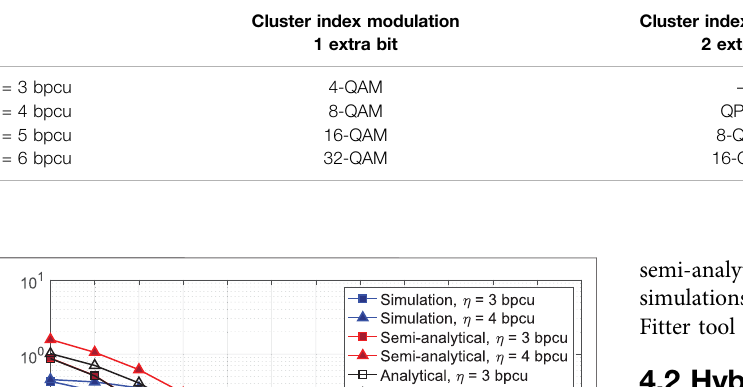
TABLE 2 | Simulation parameters.